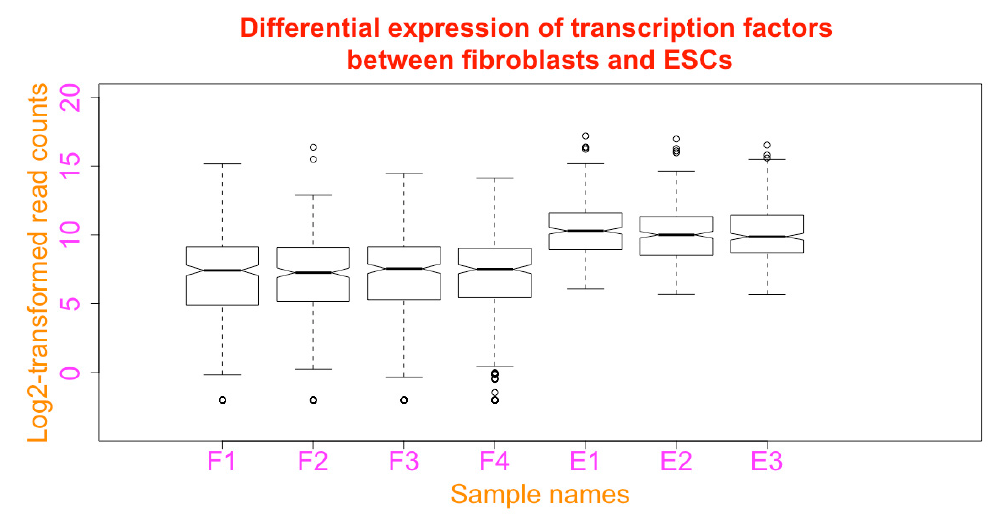
Figure 24. Change the limits of axes using the functions xlim and ylim .